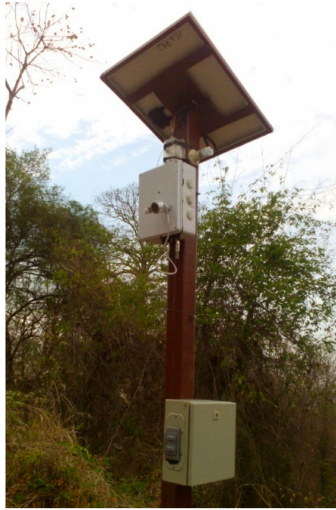
Figure 3. Network of acoustic and environmental